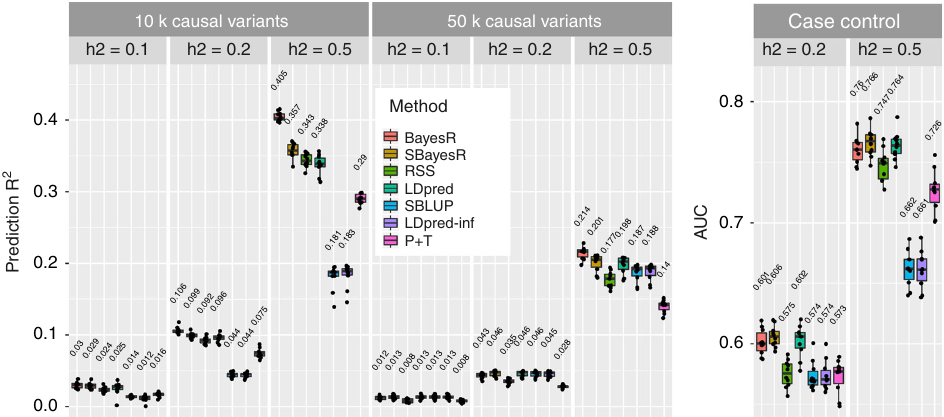
Fig. 1 Prediction accuracy performance for the UKB genome-wide simulation. Each panel displays boxplot summaries of the prediction R 2 ( y -axis) or area under receiver-operating characteristic curve (AUC), in the 10,000 individual validation data set for each method ( x -axis) across the 10 replicates. The simulation study contained eight scenarios that varied in the number of causal variants, 10,000 (10k) and 50,000 (10,000), and the true simulated heritability h 2 ¼ ð 0 : 1 ; 0 : 2 ; 0 : 5 Þ . The two genetic architecture scenarios generated were 10,000 causal variants sampled under the SBayesR model, that is, 2500, 5000 and 2500 variants from each of N (0, 0.01), N (0, 0.1) and N (0, 1) distributions, respectively, and 50,000 causal variants sampled from a standard normal distribution. Case – control phenotypes were generated from the liability threshold model with a simulated disease prevalence of 0.05 and the 10,000 causal variant genetic architecture. In each panel, LDpred has two boxplot summaries, one that has been optimised for the polygenicity parameter and the other is LDpred-inf, which is displayed for comparison with SBLUP. LDpred and SBLUP were initialised with the true heritability parameter. The mean prediction accuracy across the 10 replicates is displayed above the boxplot for each method. The centre line inside the box is the median, the bottom and top of the box are the fi rst and third quartiles, respectively (Q1 and Q3), and the lower and upper whiskers are Q1 – 1.5 IQR and Q3 + 1.5 IQR, respectively, where IQR = Q3 – Q1. The points depict the prediction accuracy for each n = 341,633), forced expiratory volume in 1 s (FEV, n = 317,502),